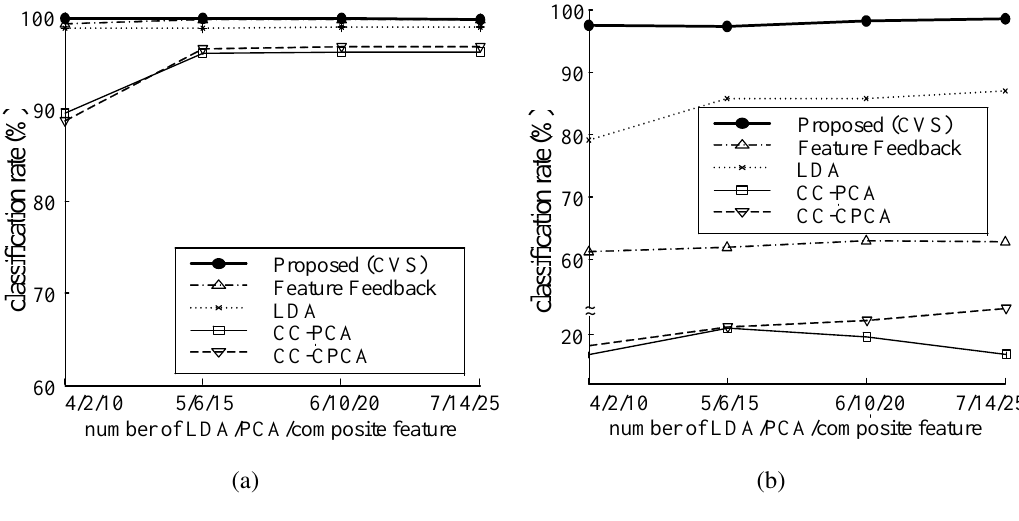
Figure 8. Classification rates for the electronic nose data. ( a ) Classification rates for the original electronic nose data. ( b ) Classification rates for the electronic nose data with Gaussian noise (std